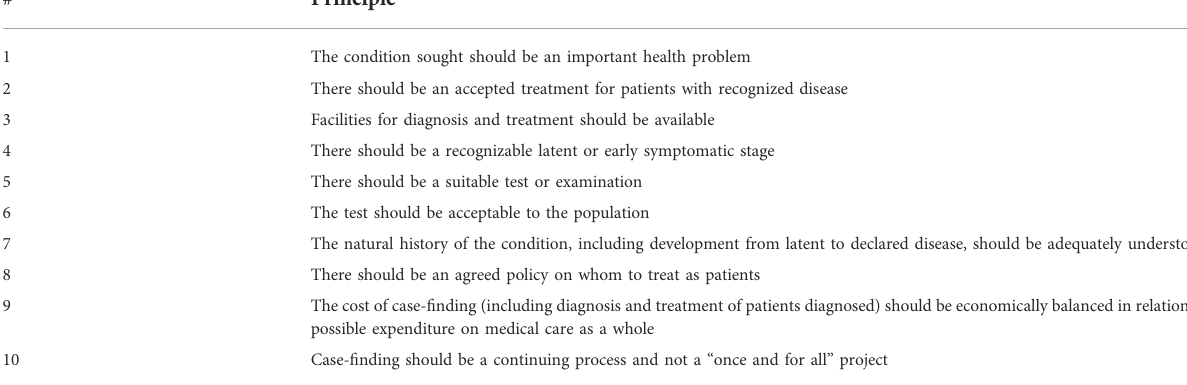
TABLE 1 Wilson and Jungner ’ s principles for disease screening (Wilson and Jungner,